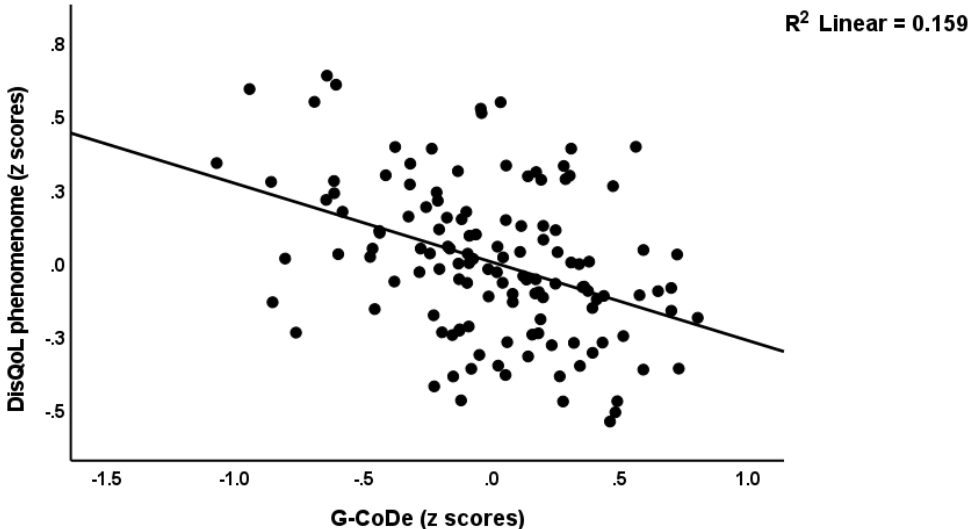
Figure 3. Partial regression of the DisQol phenomenome, a latent vector extracted from three Sheehan disability (Dis) domains and four WHO-Quality of Life (QoL) domains, on the generalized cognitive decline (G-CoDe) of schizophrenia, a latent vector extracted from cognitive test results, after adjusting for the effects of confounders.